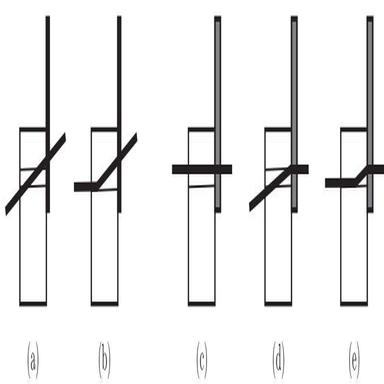
Failure modes for steel-to-timber connections in accordance with EN 19951-1-1: (a) tilting, (b) bending in board, (c) bearing, (d) bending at steel plate and (e) double bending.